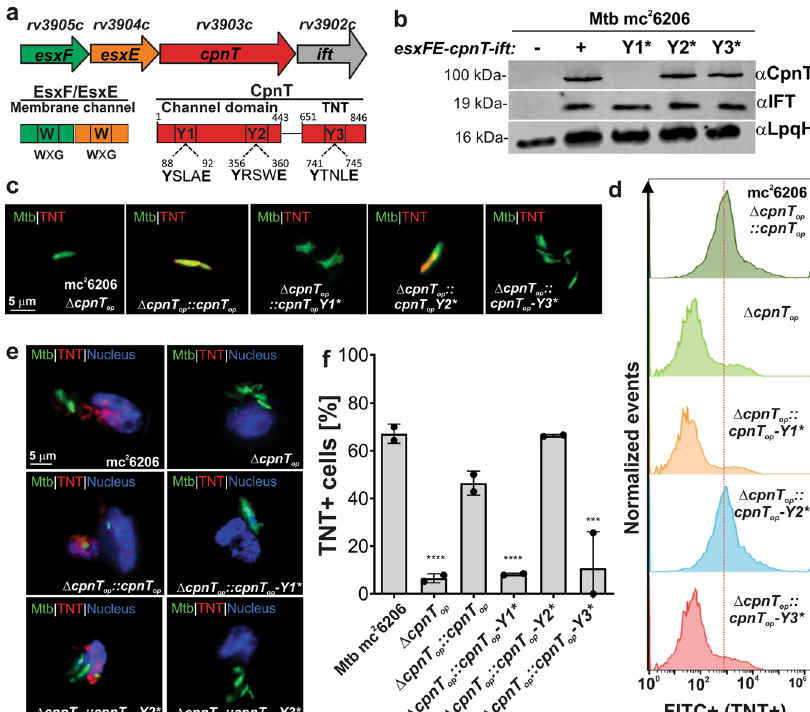
Fig. 1 ESX motifs are required for surface accessibility of CpnT in M. tuberculosis . a The cpnT locus of Mtb. The positions of the three putative ESX motifs labeled Y1, Y2, and Y3 of CpnT are indicated. b Immunoblot of Mtb whole-cell lysates probed with antibodies for CpnT (anti-TNT antibody) and IFT. LpqH was used as a loading control. c Detection of surface-accessible CpnT of the indicated Mtb strains using fl uorescence microscopy. The Mtb strains were labeled with the metabolic dye DMN-trehalose (green) and stained with a polyclonal antibody against the TNT domain and Alexa Fluor-594 secondary antibody (red). The yellow color indicates co-localization of TNT with the bacterial cell. d Surface accessibility of CpnT by fl ow cytometry. The indicated Mtb strains were stained with a polyclonal antibody against the TNT domain and Alexa Fluor-488 secondary antibody. The mean fl uorescence of Mtb cells is displayed in histograms. e Secretion of TNT into the cytosol of Mtb-infected macrophages. The indicated Mtb strains were labeled with the metabolic dye DMN-Trehalose (green) and used to infect THP-1 macrophages at an MOI of 10:1. The macrophages were permeabilized with Triton X-100 48 h after infection, stained with an anti-TNT antibody and Alexa Fluor-594 secondary antibody (red). The macrophage nuclei were stained with DAPI. f Quanti fi cation of TNT-positive macrophages from images shown in e . Macrophages were scored as TNT-positive when distinct red punctae were observed as compared with the Mtb cpnT operon deletion mutant ( Δ cpnT op ). Data are represented as mean ± SEM of at least two independent experiments ( n ≥ 2). Shown are representative images/blots of at least two independent experiments ( n ≥ 2). Asterisks indicate signi fi cant differences (* p value ≤ 0.05, ** p value ≤ 0.01, *** p value ≤ 0.001, **** p value ≤ 0.0001, calculated using the one-way ANOVA with Dunnett ’ s correction) compared with the Mtb mc 2 6206 strain. Source data are provided in the Source Data fi